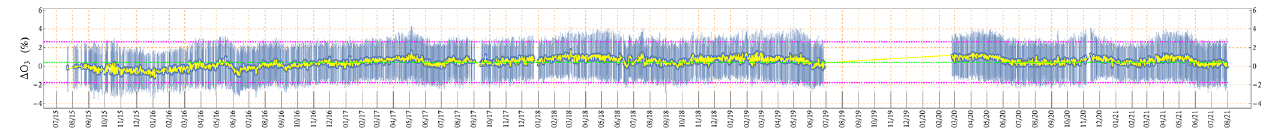
Figure 24. Comparison of synoptic EPIC O 3 with MERRA-2 assimilated O 3 : time series of mean daily differences and standard deviations for EPIC observations with VZA ≤ 70 ◦ .